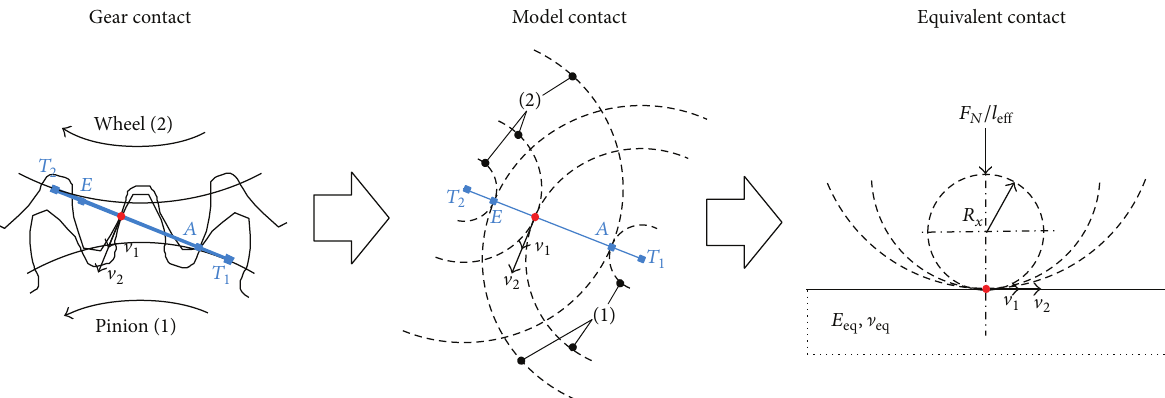
Figure 1: Line contact in a spur gear and its simplification to a model (disc) contact and to an equivalent